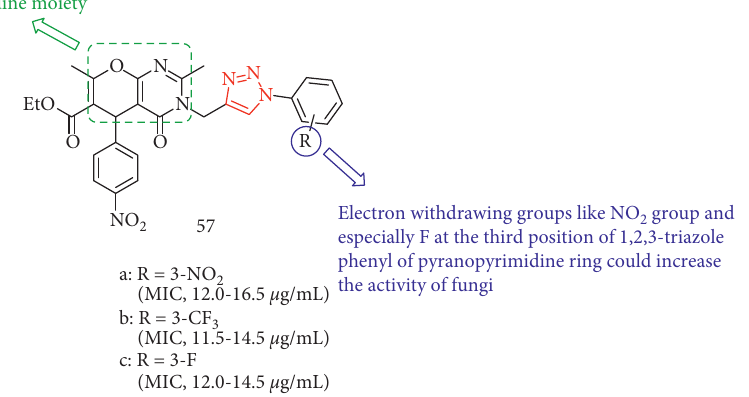
Figure 13: Chemical structure of pyrano-[2,3-d]-pyrimidine-attached 1,2,3-triazole derivatives.